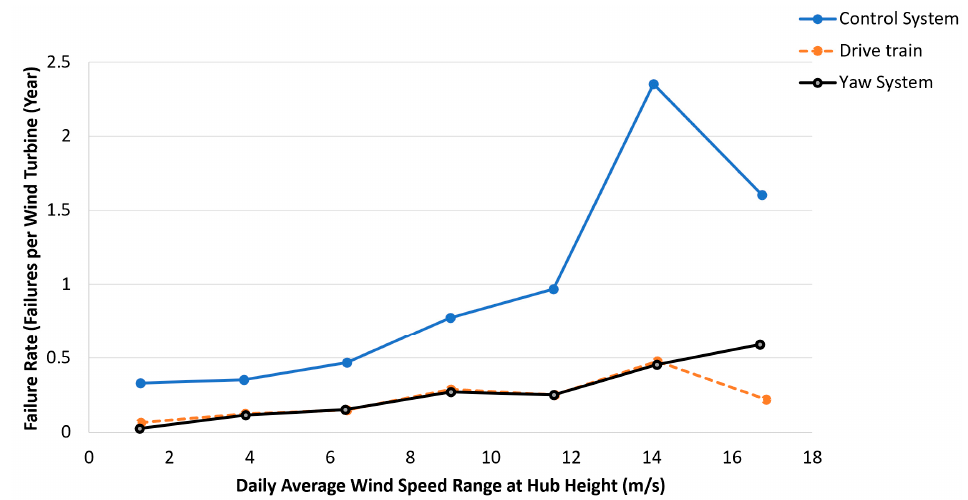
Figure 15. Yearly rate of failure for wind turbine having a daily average wind sped at hub height [90].